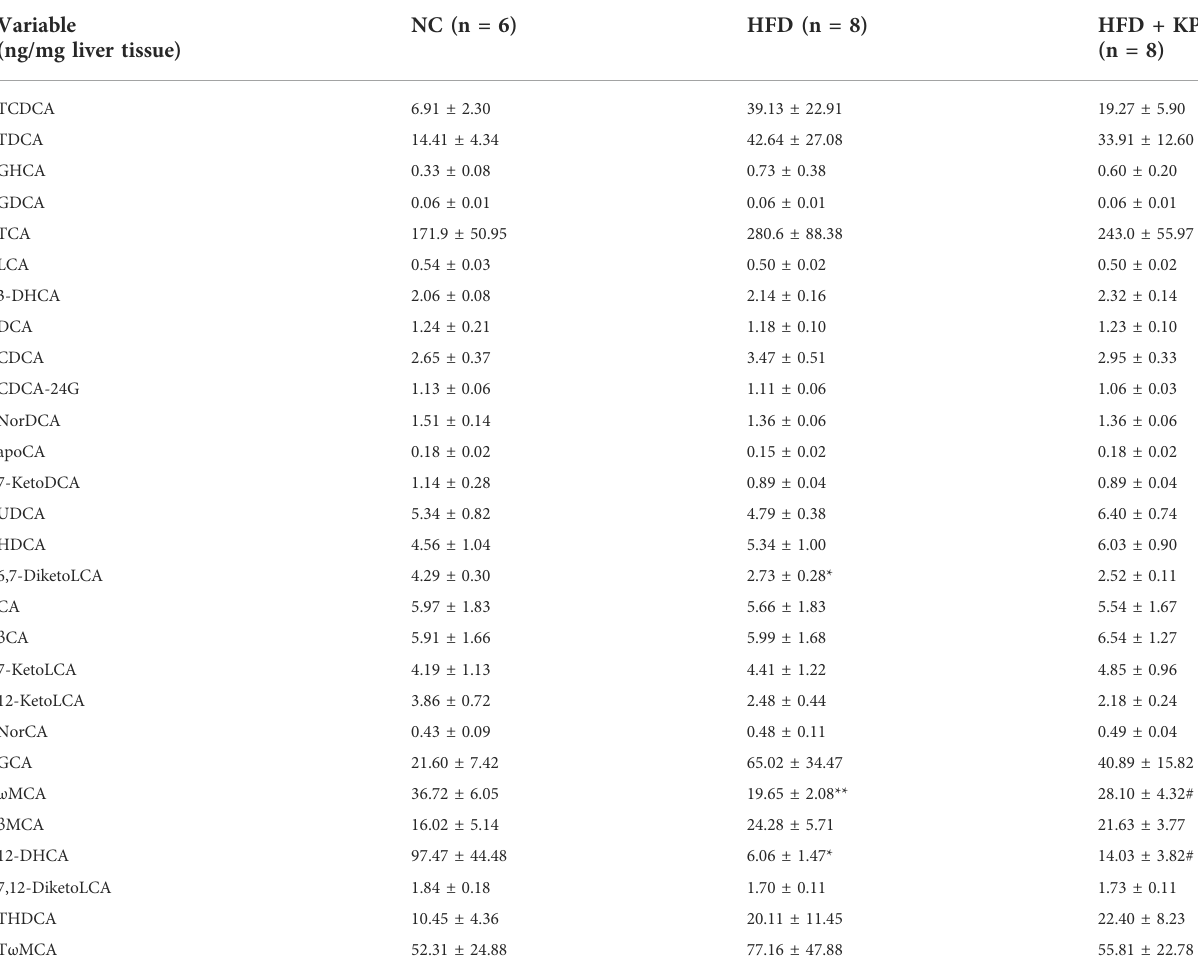
TABLE 3 Liver BA levels in different groups. Variable (ng/mg liver